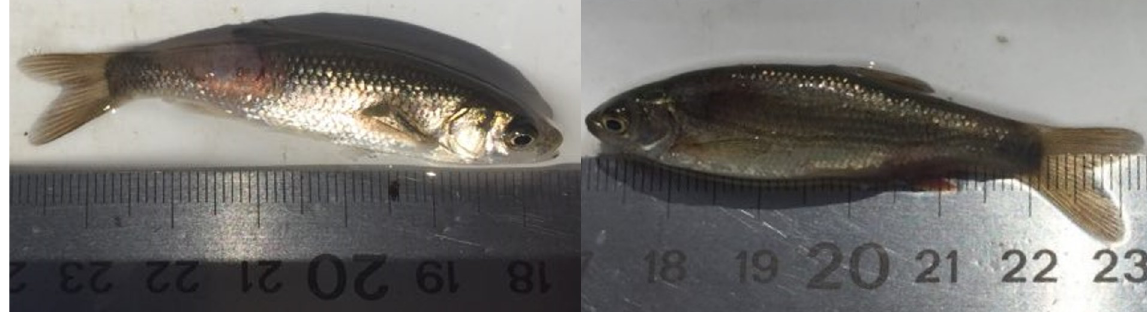
Fig 1. Examples of individuals collected during sampling. Left: S . pyrenaicus individual presenting an extensive area of epidermal loss with hyperaemia in the right dorso-lateral region of the pedunculus; Right: I . lusitanicum individual without skin lesions.